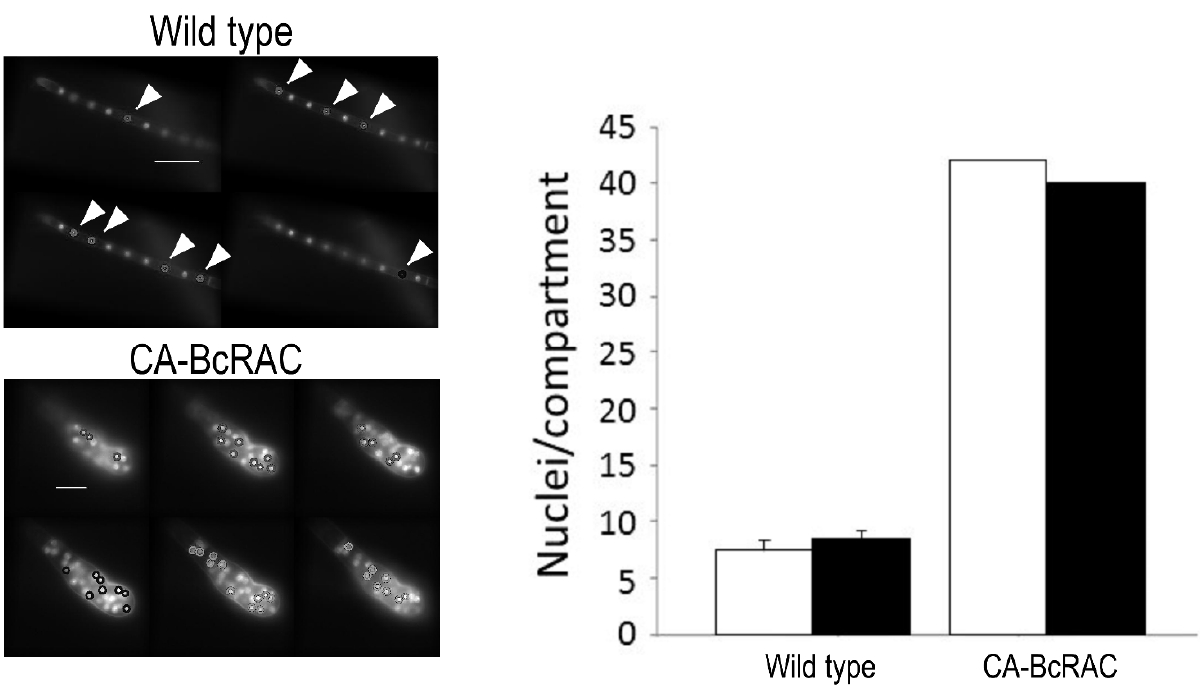
FIGURE 2: Nuclei counts in hyphae of wild type and CA-BcRAC strain. Hyphae were harvested, stained with Hoechst 33342 and visualized at 400x magnification. Images were captured using the z-stack function with 0.3 µm sections. Images show consecutive z sections of wild type (top) and CA-BcRAC (bottom) hyphae. In each section the most distinct nuclei are automatically marked by the software (also manually marked by arrows in images of the wild type hyphae). Scale bar = 20 µm. The number of nuclei between the hyphal tip and the first septum was counted manually (white bars) and by the Layer module of the SCAN © software (black bars). For the wild type, the graph shows the average number ± s.d. of nuclei counted in 30 hyphal segments. For CA-BcRAC graph shows the actual number of nuclei counted in a specific hyphal